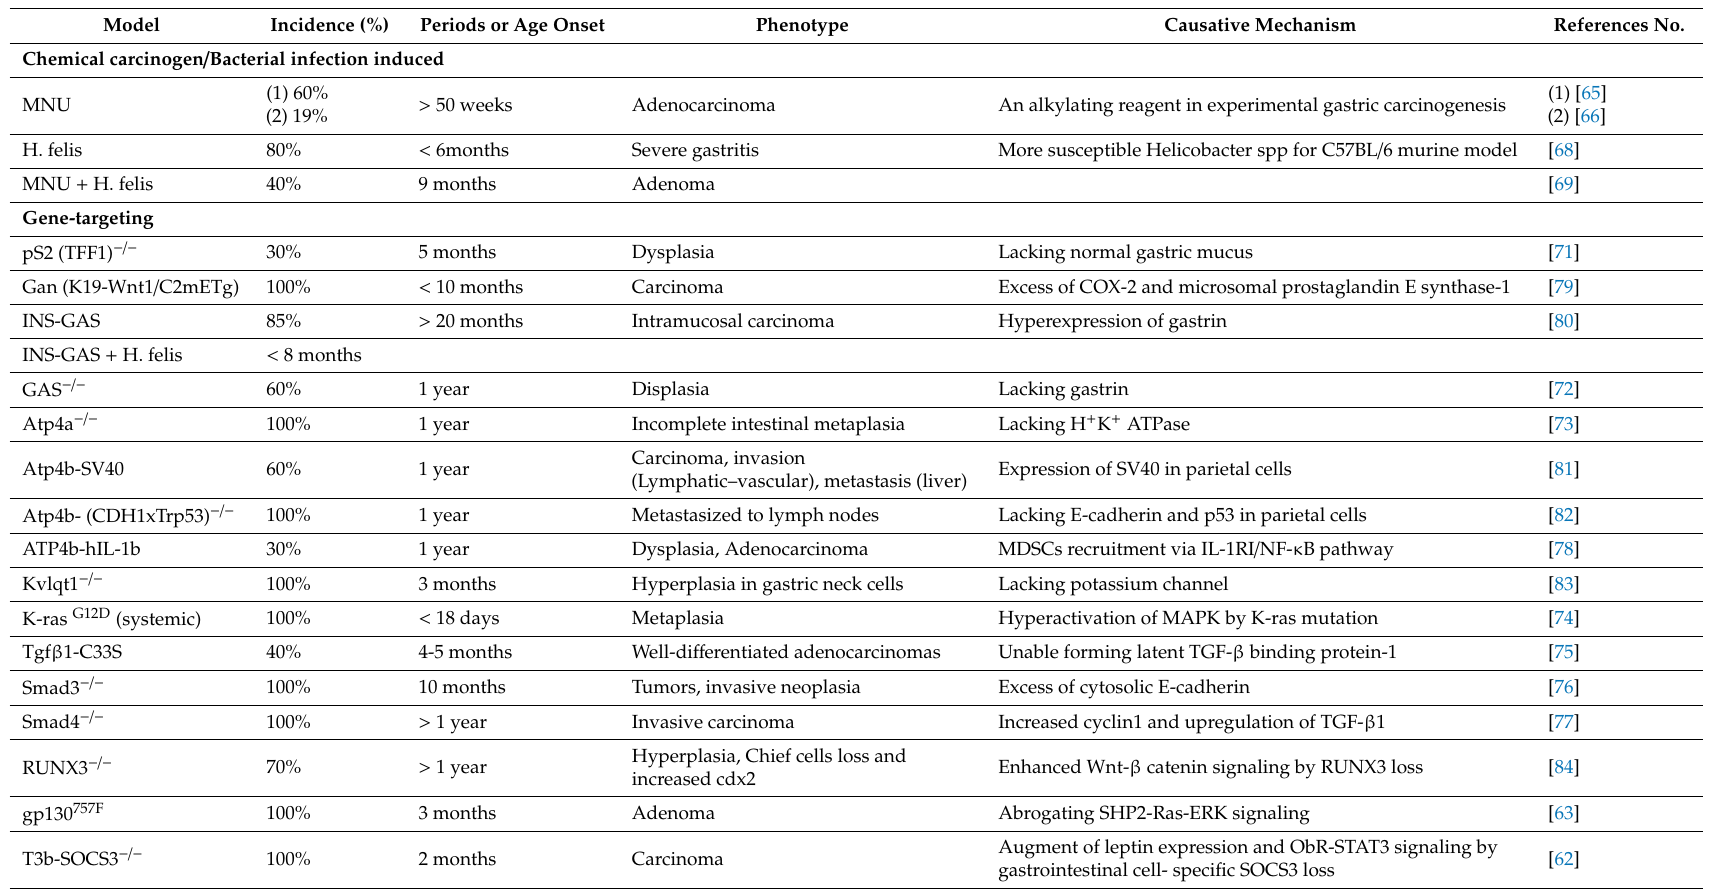
Table 1. Murine model of gastric